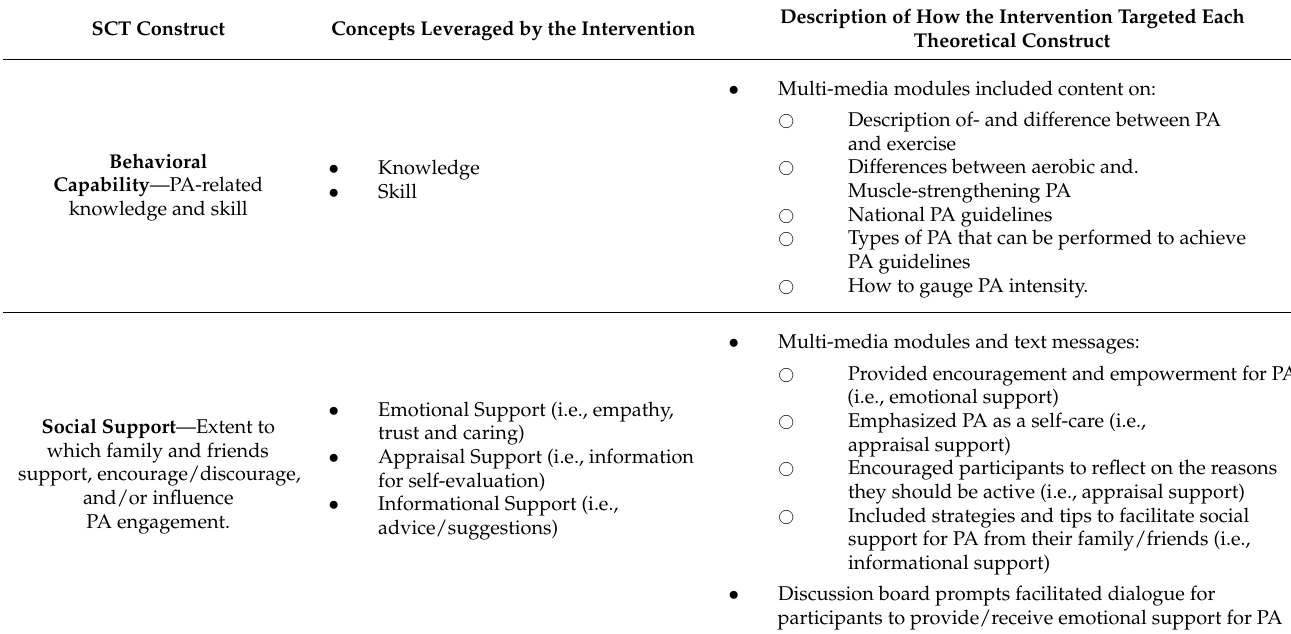
Table 2. Social Cognitive Theory (SCT) constructs addressed by the Smart Walk